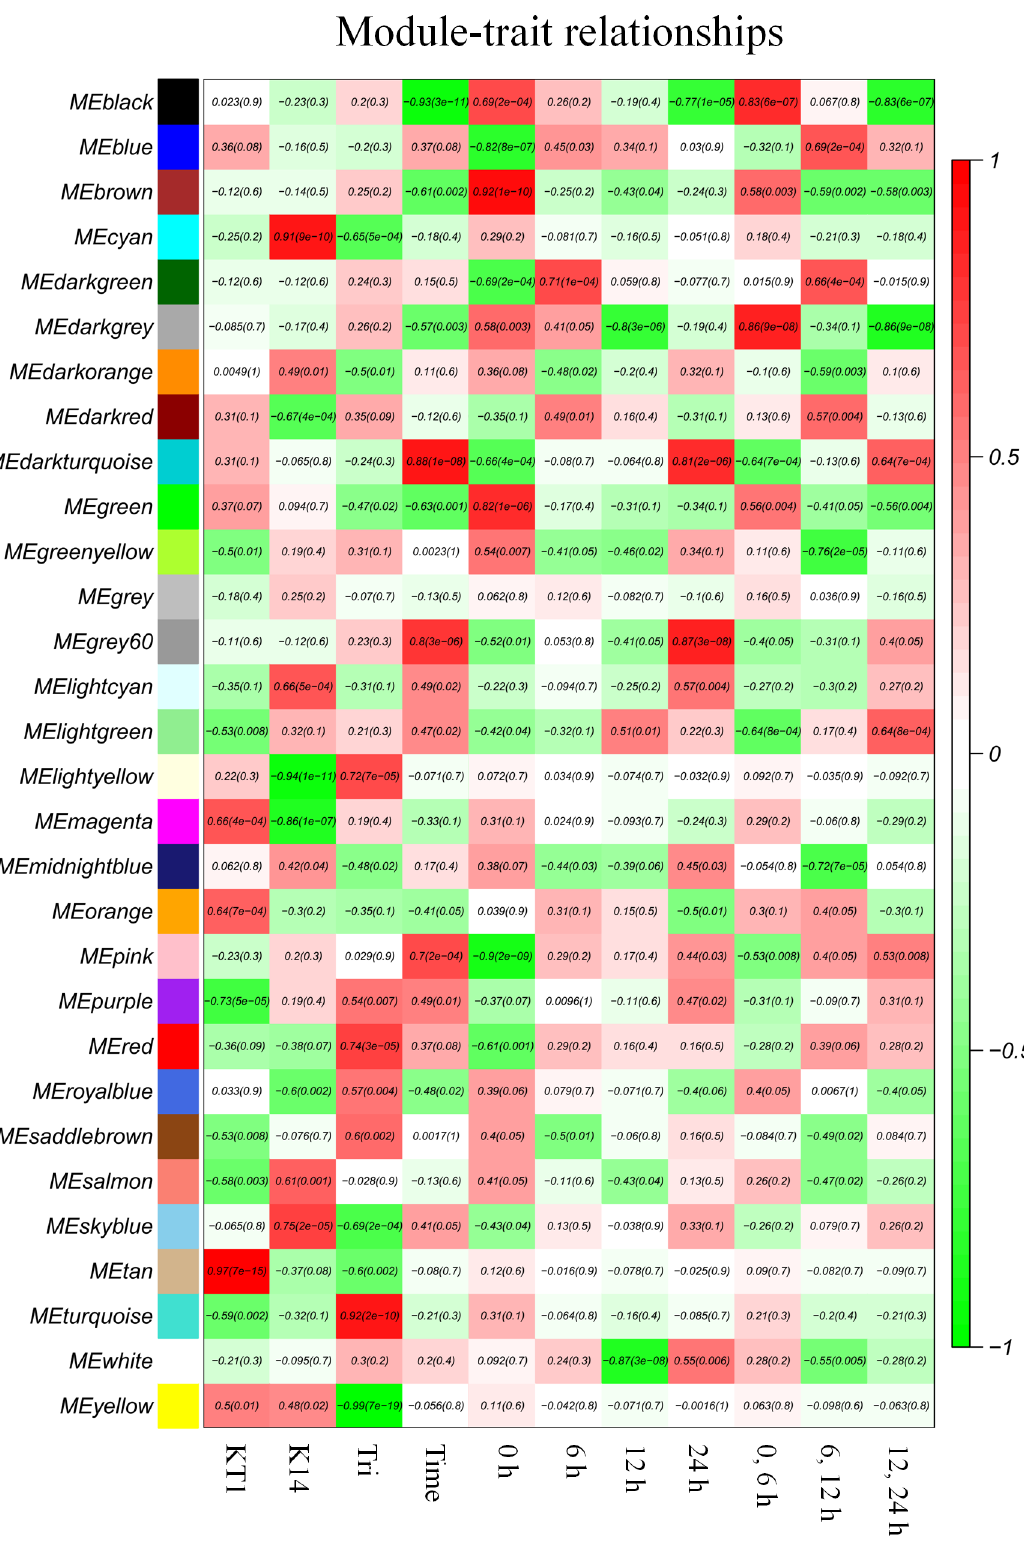
Fig 3. Module correlation coefficients from weighted gene co-expression network analysis. Variables shown on x-axis are genotype (KT1, K14, Tri), time, duration of drought stress treatment (0, 6, 12, 24 h), and difference between two treatment times (0, 6 h; 6, 12 h; 12, 24 h).